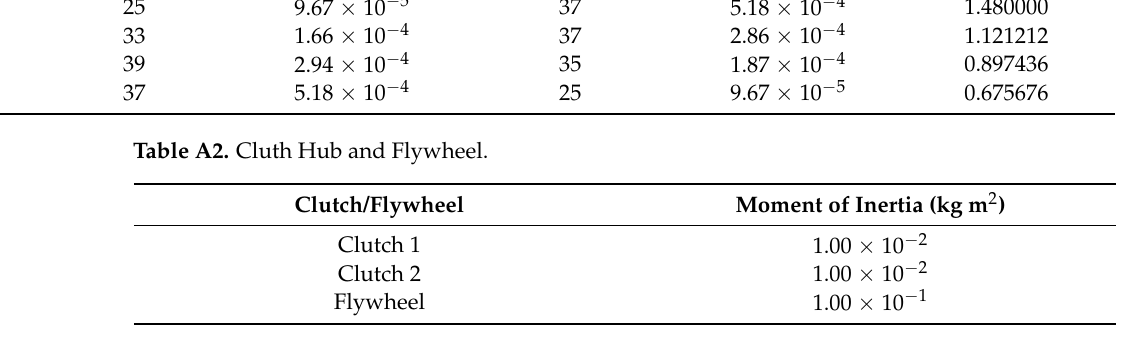
Table A3. Gear pairs and lubrication